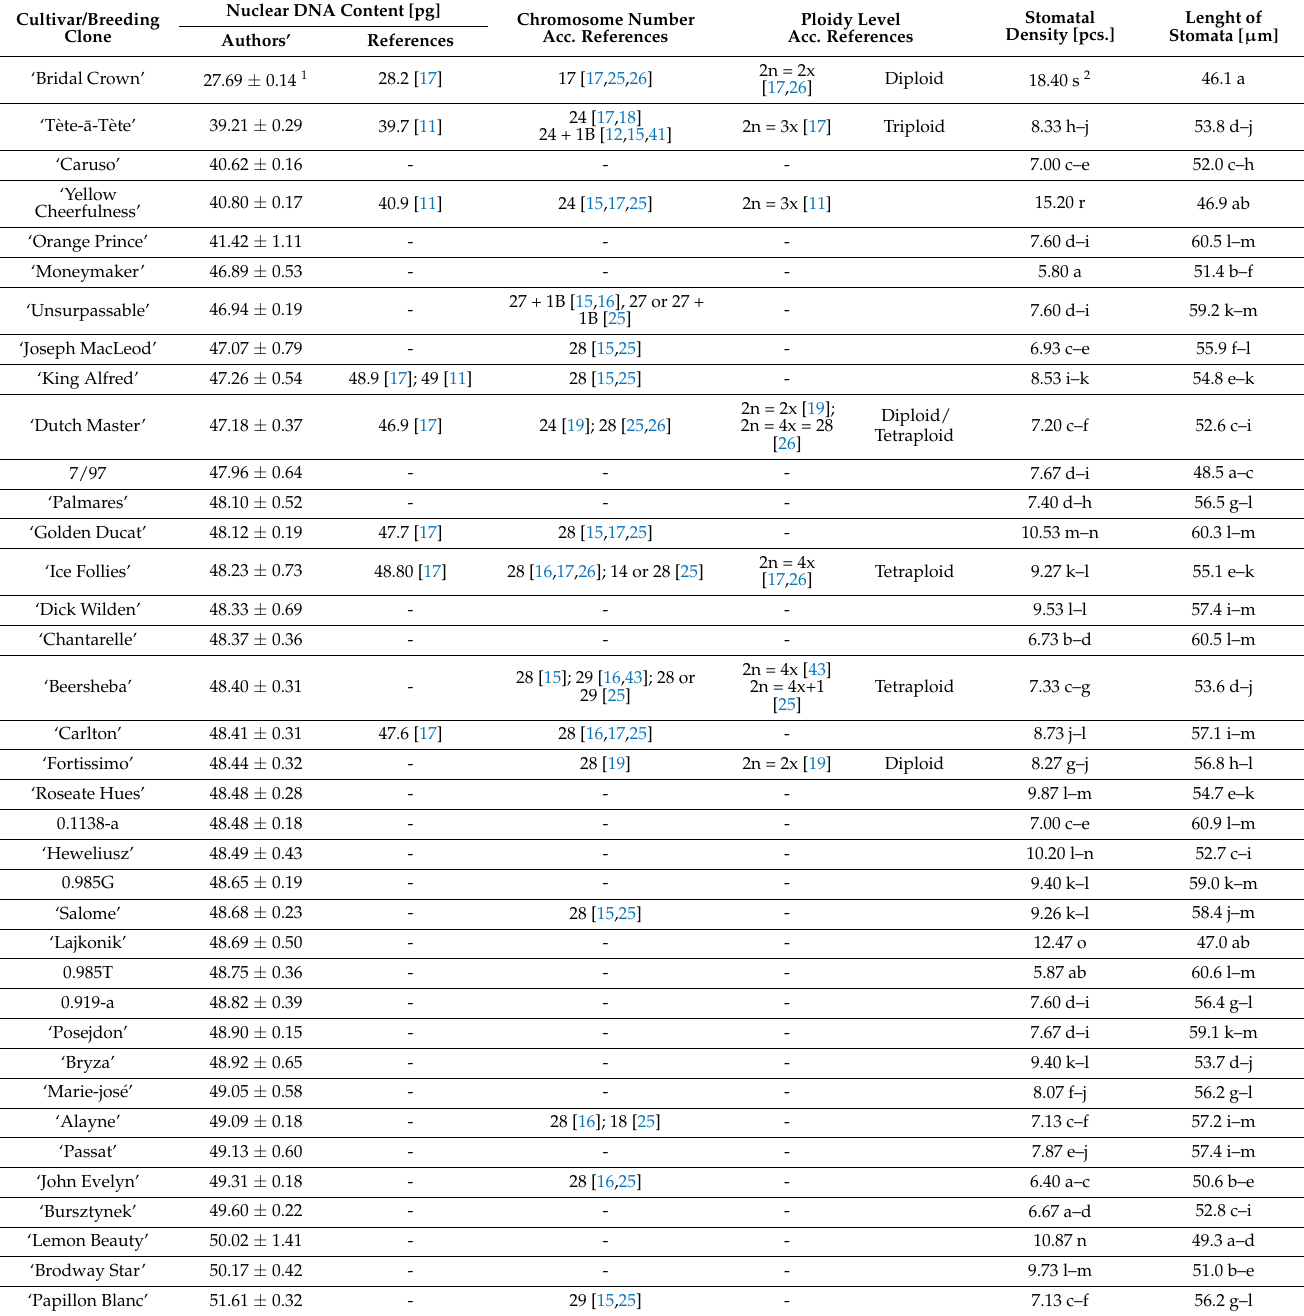
Table 2. Nuclear DNA content, chromosome number, and stomata number and length of 38 cultivars and breeding clones of